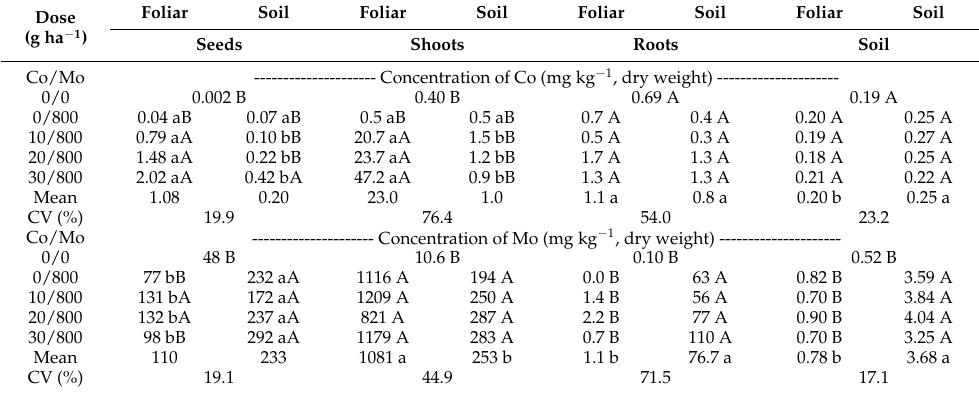
Table 1. Cobalt and Mo concentrations in seeds, shoots, roots, and soil as a function of foliar and soil Co and Mo application in soybean parent plants during